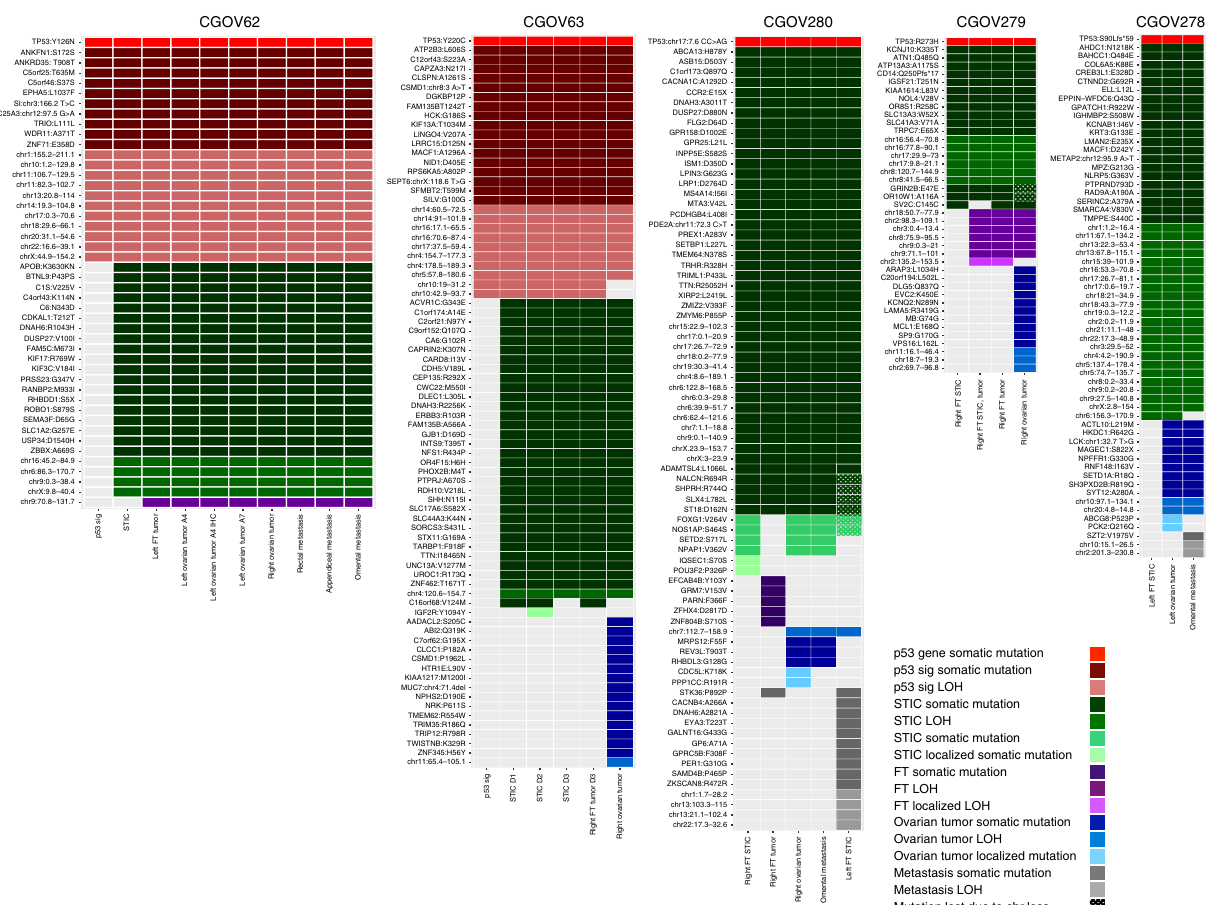
Fig. 2 Somatic mutation and allelic imbalance pro fi les among different tumor lesions. Somatic mutations and segments of allelic imbalance detected by whole-exome analyses are indicated as colored cells in rows for all patients. Darker shades of each color indicate somatic mutations while lighter shades indicate allelic imbalances. The tumor samples analyzed for each patient are indicated in columns (p53 sig, p53 signature; STIC, serous tubal intraepithelial carcinoma). For ovarian tumors in CGOV62 and STIC lesions in CGOV63 multiple blocks are indicated, including one ovarian tumor where multiple sections were analyzed after hematoxylin and eosin staining or after immunohistochemistry (IHC) staining of p53. These analyses indicated that staining methods did not affect detection of somatic alterations. The color of mutations indicates the degree of relatedness among tumor samples: red, shared among all tumor samples with TP53 highlighted at the top row; green, shared among all tumor samples except p53 signature lesion; purple, shared among fallopian tube tumor and omental metastasis; blue indicates mutations that were fi rst detected in the ovarian tumors; and gray indicates mutations that were only detected in metastatic lesions. Additional color shades or patterns indicate mutations that are localized to speci fi c lesions or lost due